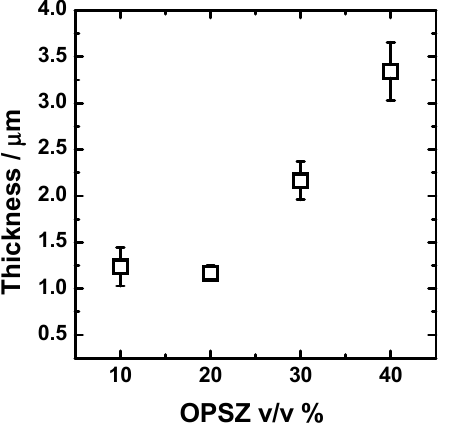
Figure 3. Effect of the dilution in butyl acetate on the dry film thickness of the OPSZ-derived coatings.